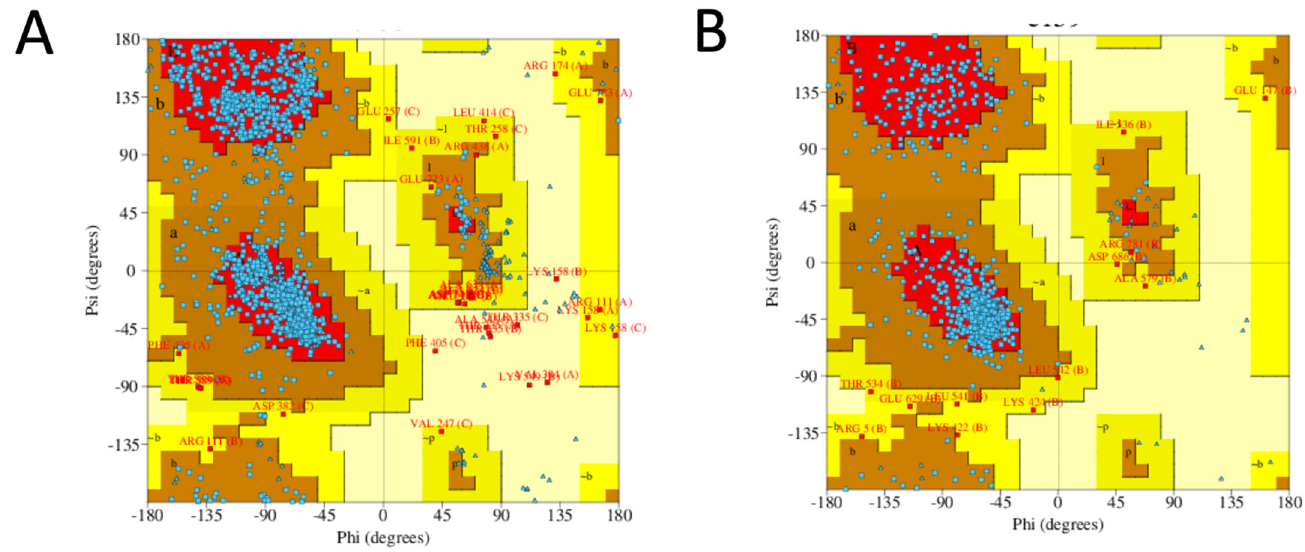
Figure 7. Ramachandran plots of the modelled ClpK protein and the template ClpB protein. ( A ) ClpK trimeric protein. ( B ) ClpB template protein. The blue dots represent the residues of each protein. The regions are denoted as follows: the most favoured regions (red), additional allowed regions (brown), the generously allowed regions (yellow) and the disallowed regions (light yellow). The figures were obtained from the ProCheck server.